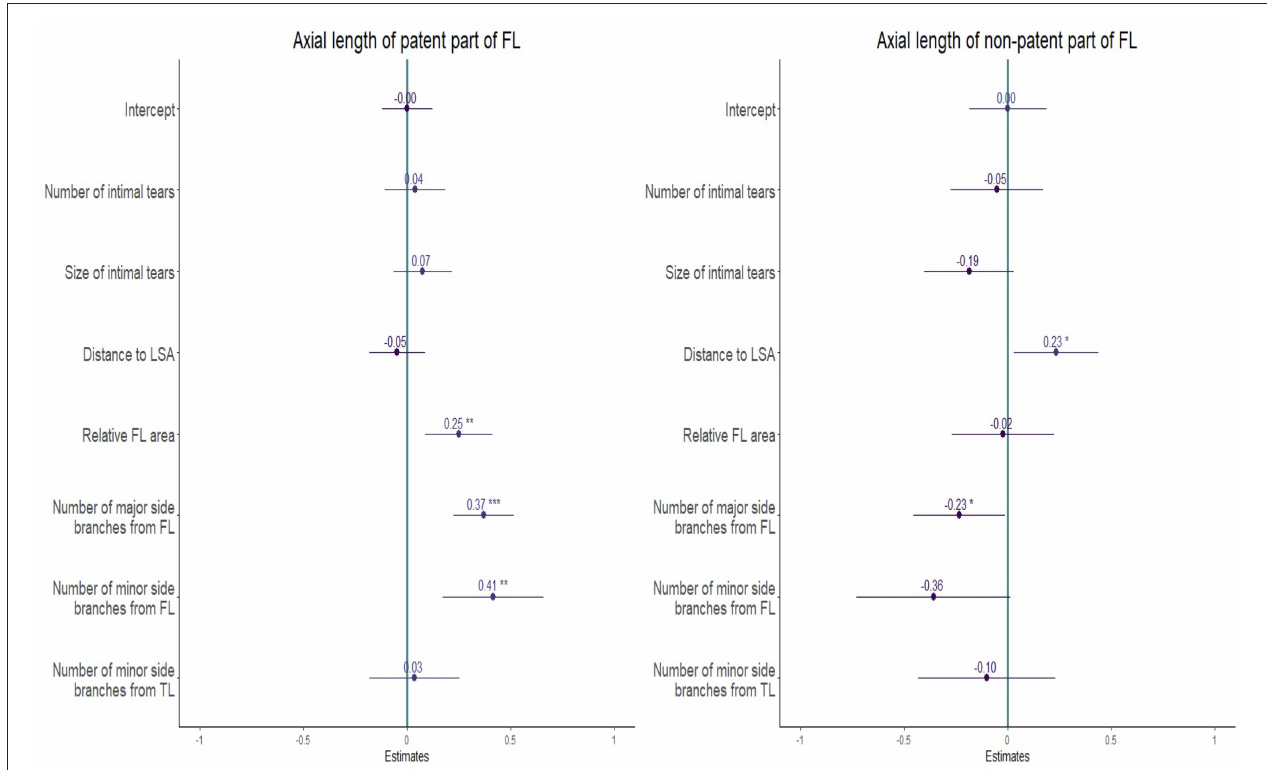
FIGURE 3 | Forest-plot of standardized beta values in a multiple regression model for the axial length of the patent false lumen (FL) (left) and the non-patent FL (right) at baseline. The dependent variables are the number and size of the intimal tears, the distance from the first intimal tear to the left subclavian artery (LSA) (distance to LSA), the relative FL area, the number of major and minor side branches arising from the FL, and the number of minor side branches arising from the true lumen (TL). Standardized by division of two standard deviations. * p ≤ 0.05; ** p ≤ 0.01, *** p ≤ 0.001. The resulting multiple linear regression model predicted the length of the patent FL with good accuracy ( R 2 = 0.77), while the prediction was somewhat lower for the non-patent FL ( R 2 =